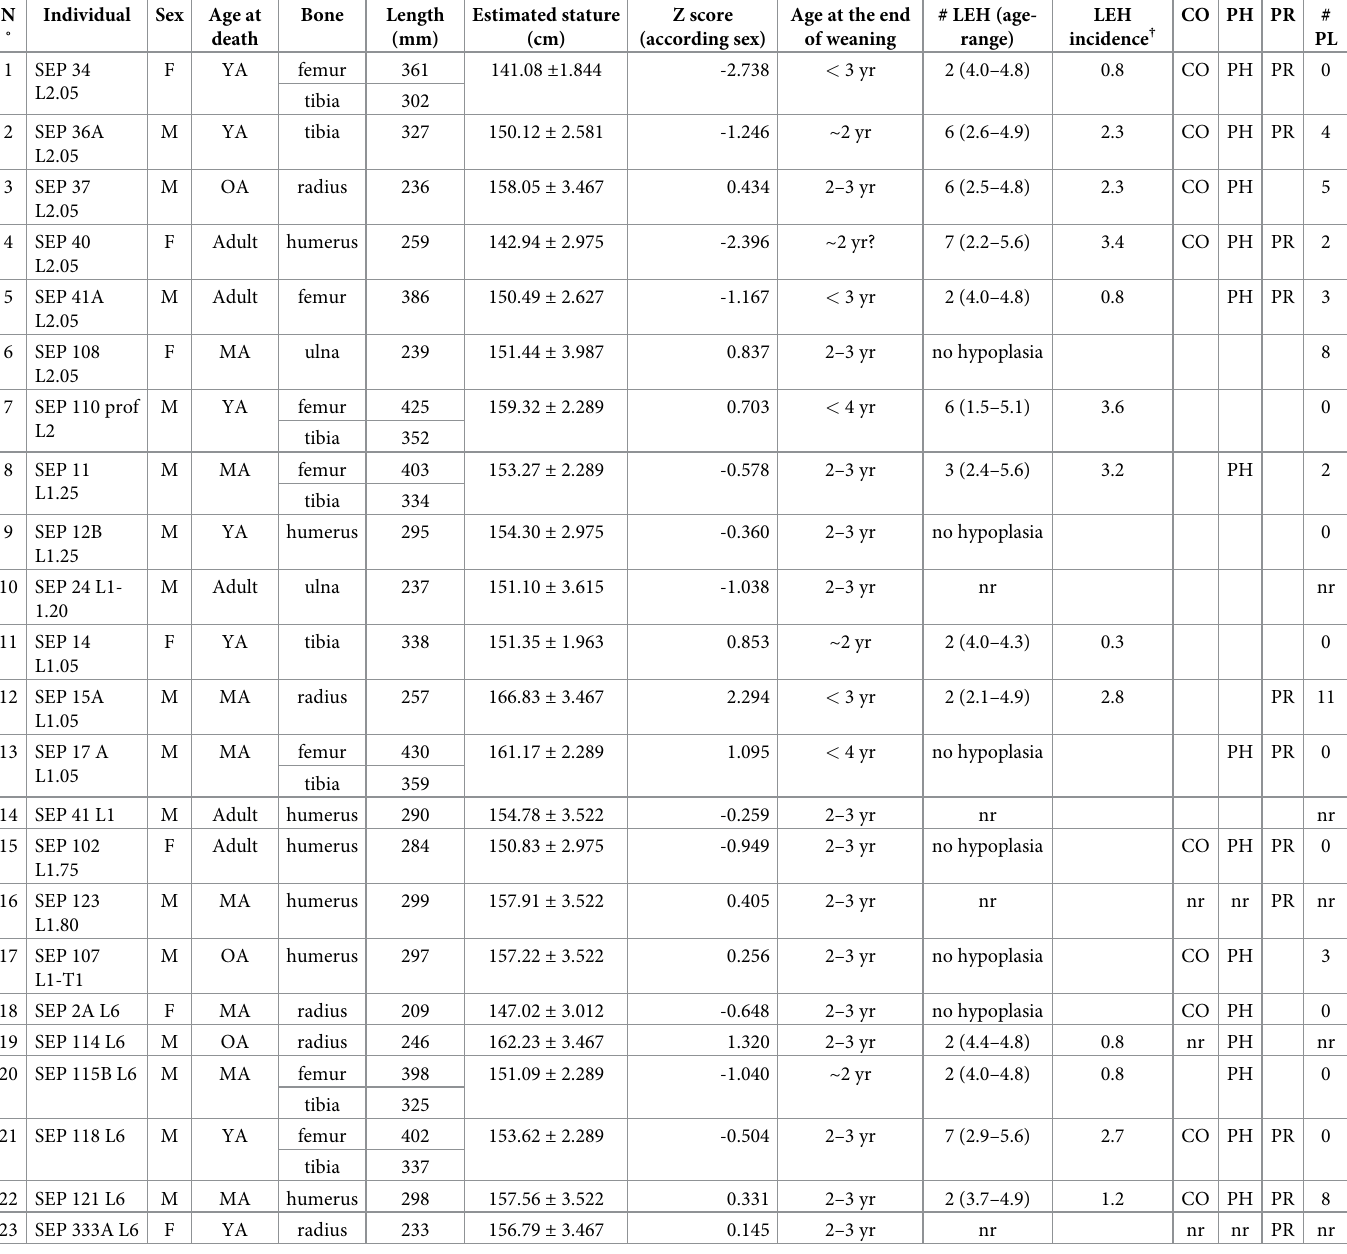
Table 2. Osteobiographic aspects in adults from Jabuticabeira II (n = 23). N